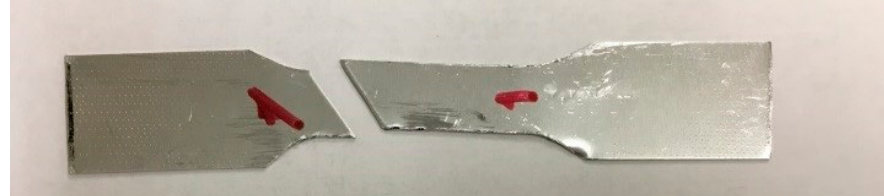
Figure 3. Tensile test results.